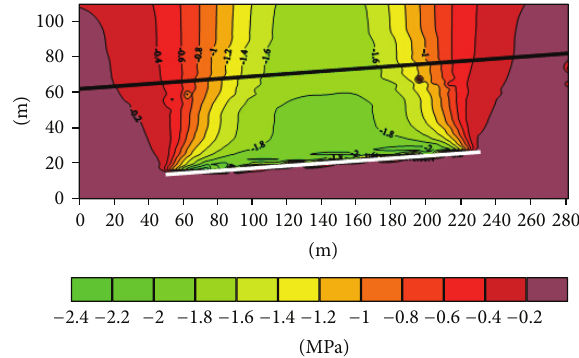
Figure 4: The vertical shift profile along the working face direction.